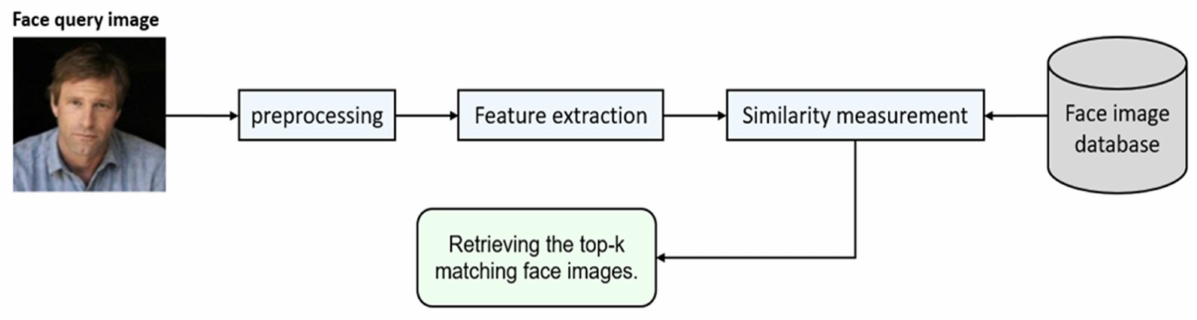
Figure 1. Generic face image retrieval